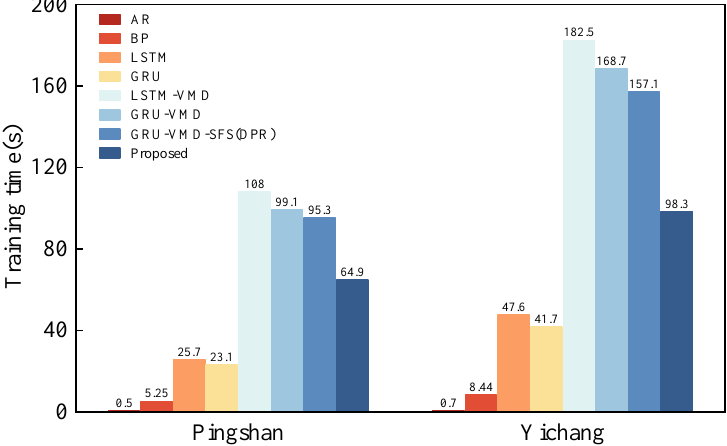
Figure 11. Training time of different methods for the two hydrological